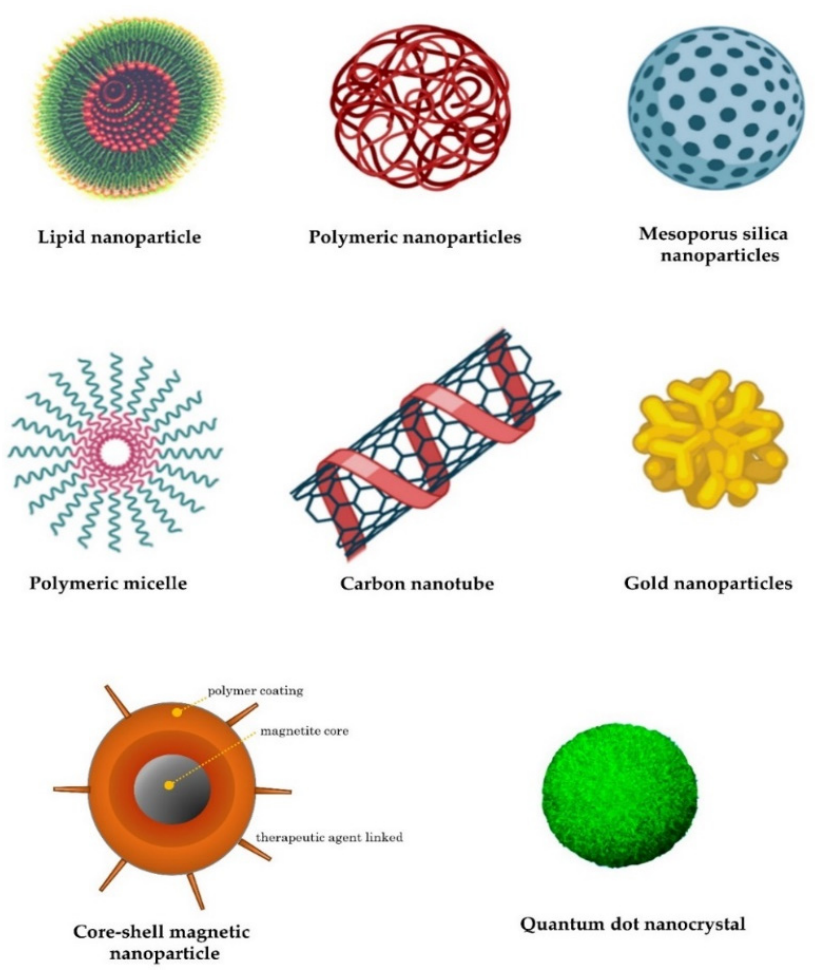
Figure 2. Examples of nanocarriers as drug-delivery systems.